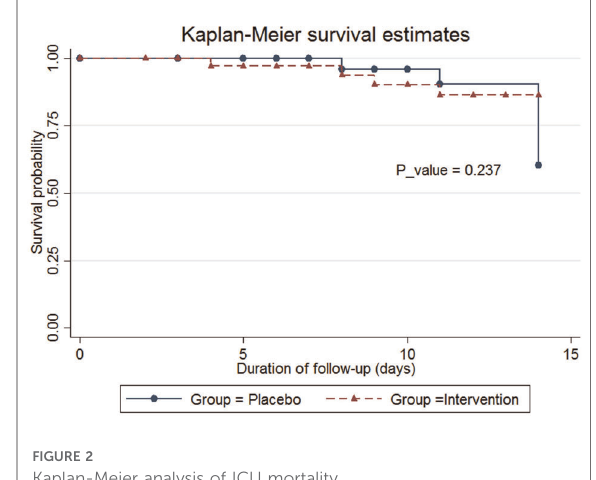
FIGURE 2 Kaplan-Meier analysis of ICU mortality.